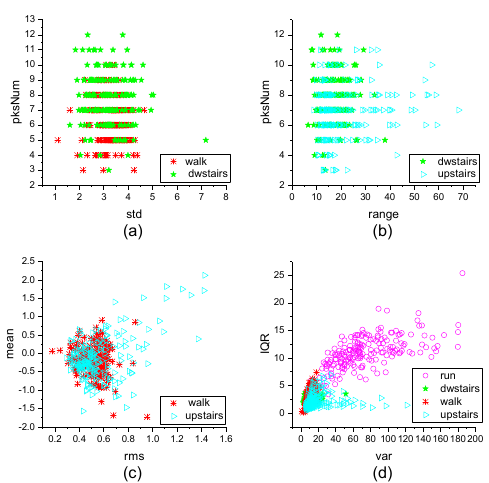
Figure 13. The effect of classification with two features extracted directly in the time domain without FRFT. ( a ) walk and dwstairs with the features std and pksNum ; ( b ) dwstairs and upstairs with the features range and pksNum ; ( c ) walk and upstairs with the features rms and mean ; ( d ) all the actions with the features var and IQR .